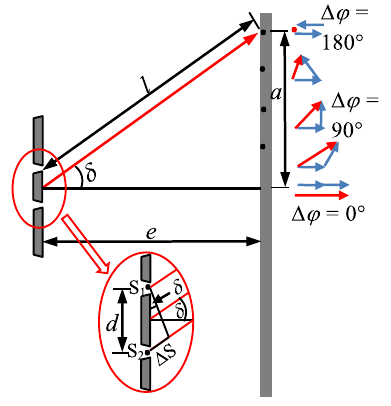
FIG. 4. P approach: Visualizing the processes that underlie the occurrence of the interference pattern in double-slit